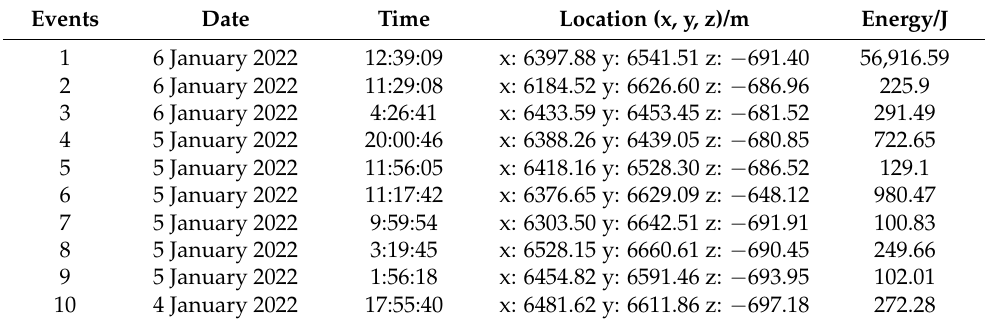
Table 1. Basic information of microseismic events in working face.